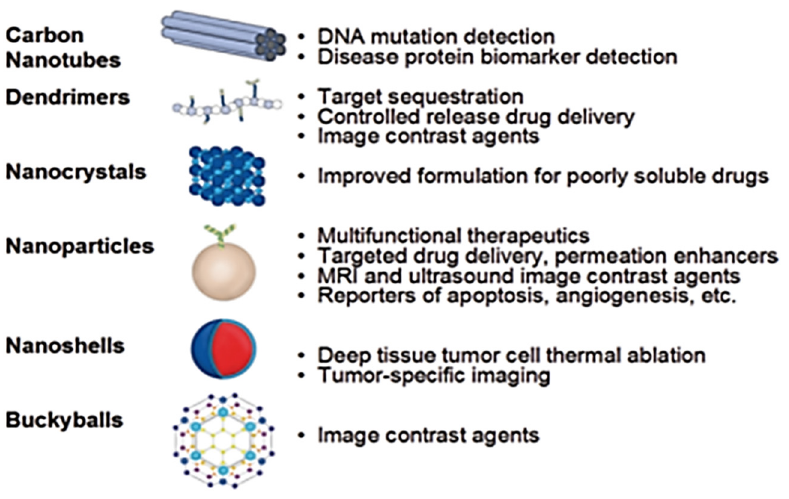
Figure 1. Various nanostructures and their possible biomedical uses [1].